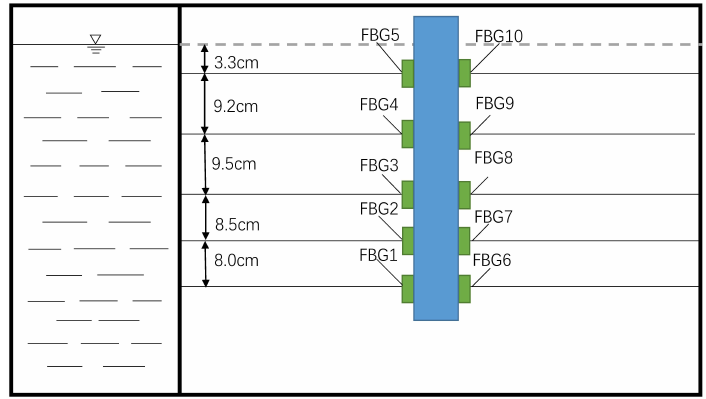
Figure 2. Layout of the fiber Bragg grating (FBG) sensors along the pile.